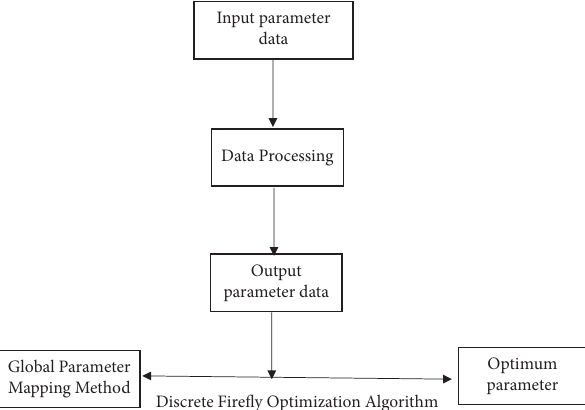
Figure 2: The algorithm of discrete firefly